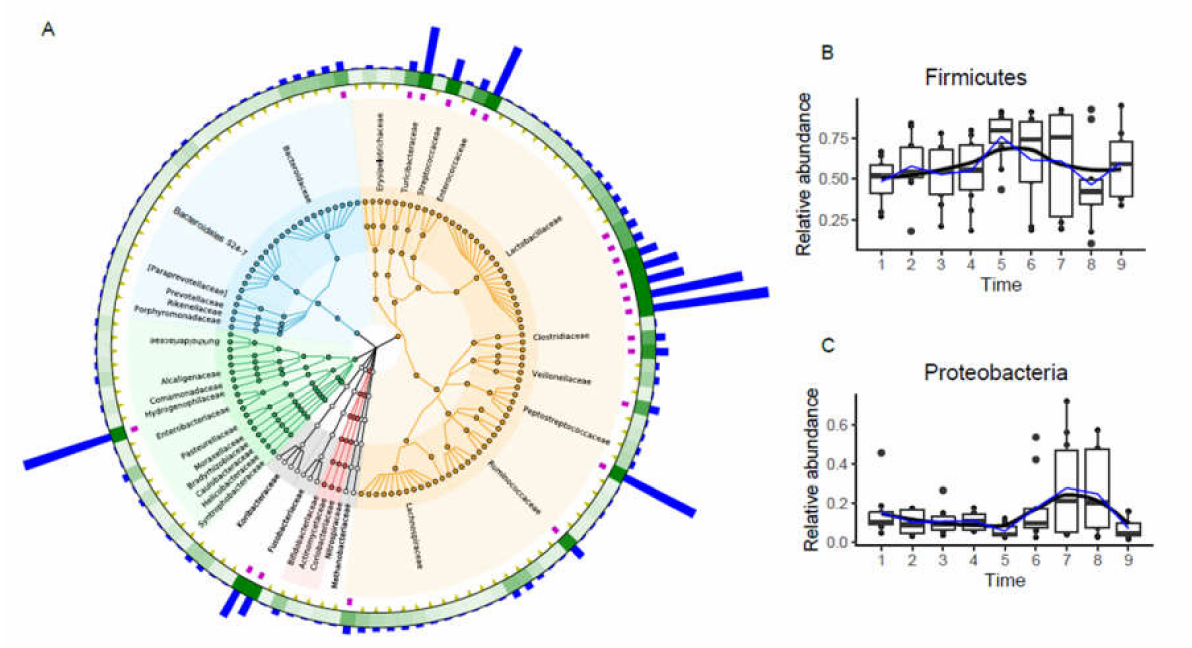
Figure 2. Different bacterial compositions based on the 16S rRNA data analysis. ( A ) GraPhlAn phylogenetic tree analysis of the fecal microbiota from the phylum to species level; ( B , C ) The temporal changes in the relative abundances of predominant bacteria ( Firmicutes and Proteobacteria ) at the phylum level. The black line represents the fitted trend line and the blue line represents the connecting line of the average